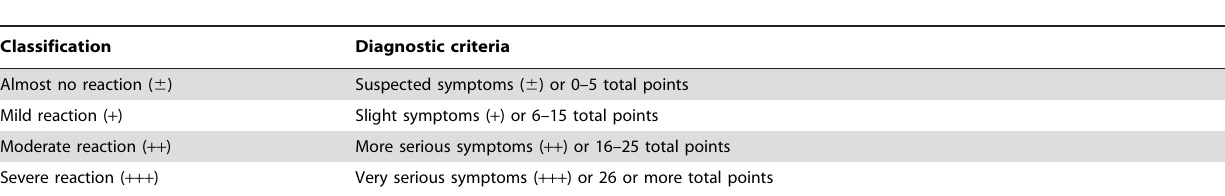
Table 2. Grading of high-altitude altitude de-acclimatization